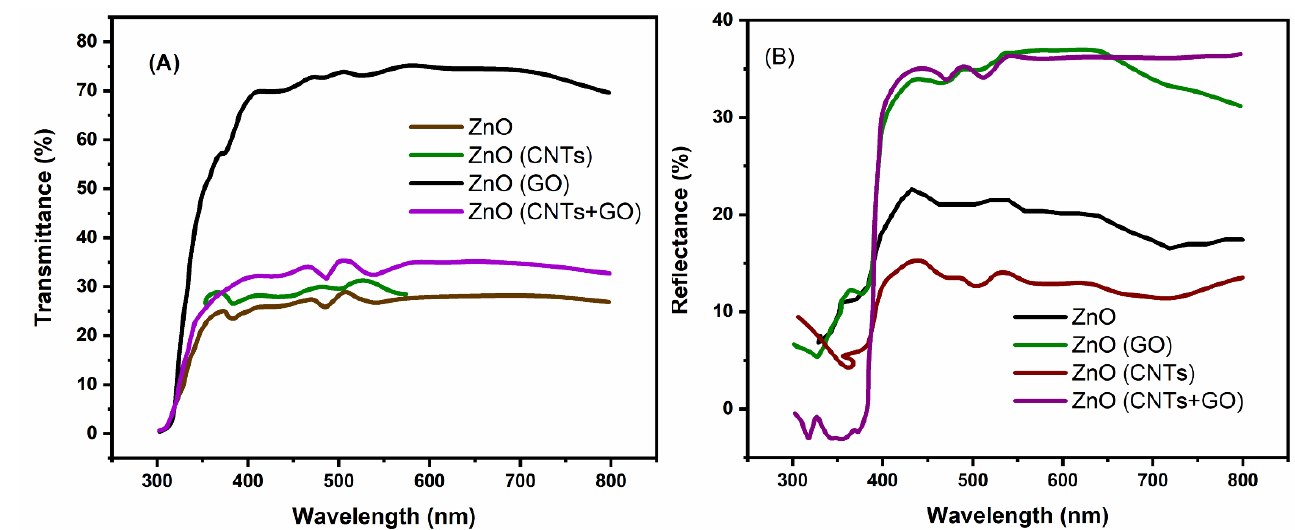
Figure 4. ( A ) Transmittance (T%), and ( B ) Reflectance (R%), spectra of Carbon/ZnO